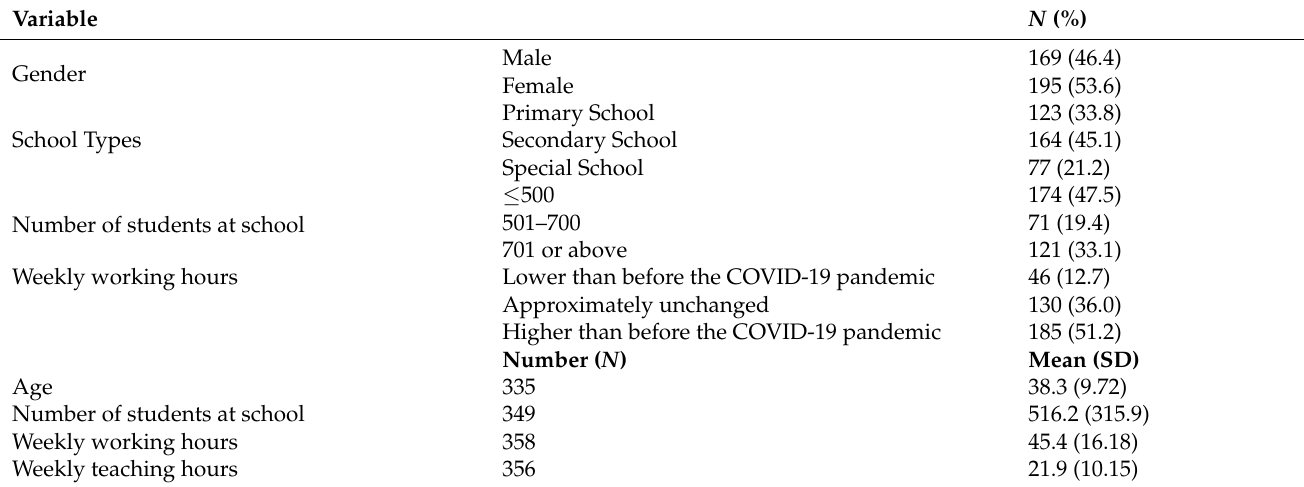
Table 1. Respondents’ demographic profiles, workload and work-related characteristics ( N = 366).